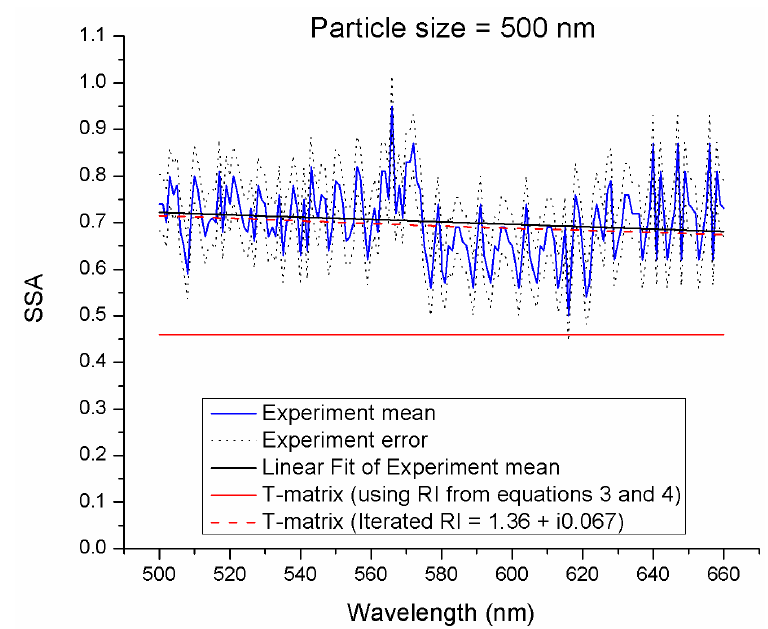
Figure 4. Comparison of experimental SSA values and T-matrix calculated SSA values using RI following Equations (3) and (4) and using RI = 1.365 + i0.067 to reproduce the experimental values for 500-nm particles collected in distilled water using an impinger.